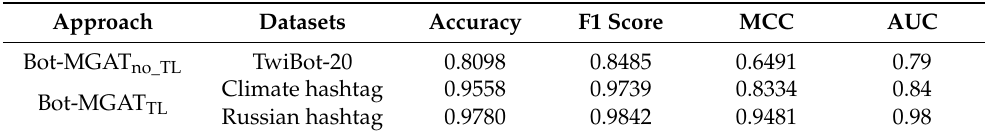
Table 7. Bot-MGAT performance with TL and without